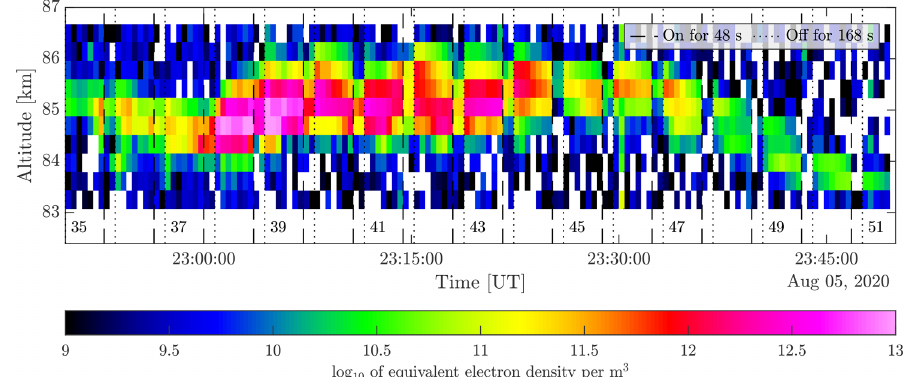
Figure 5. Backscattered power as a function of altitude and heating intervals observed during the night of 5/6 August 2020, in area